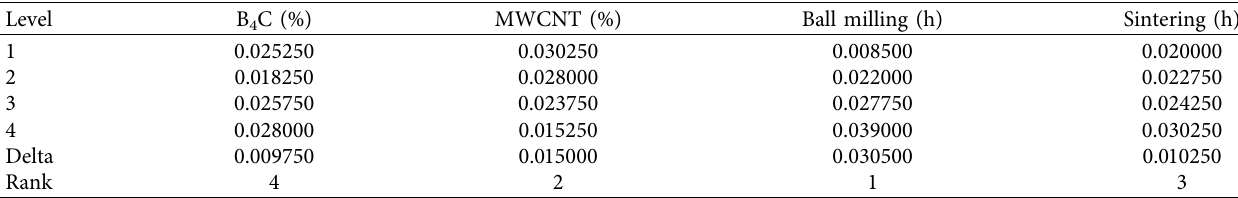
Table 4: Response table for means (wear).